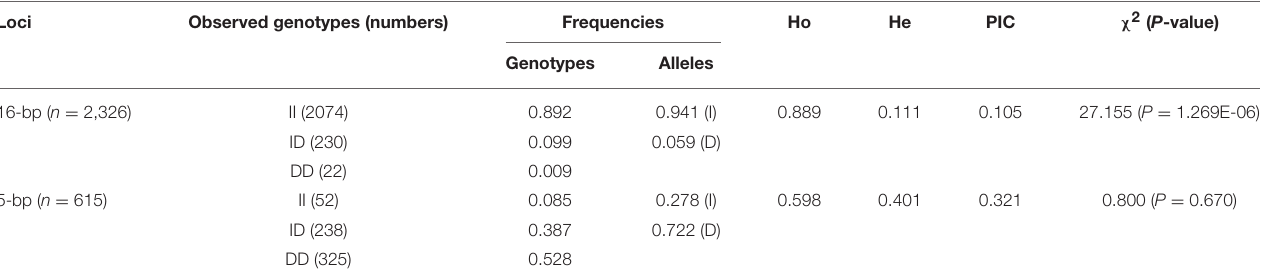
Genotypes Alleles